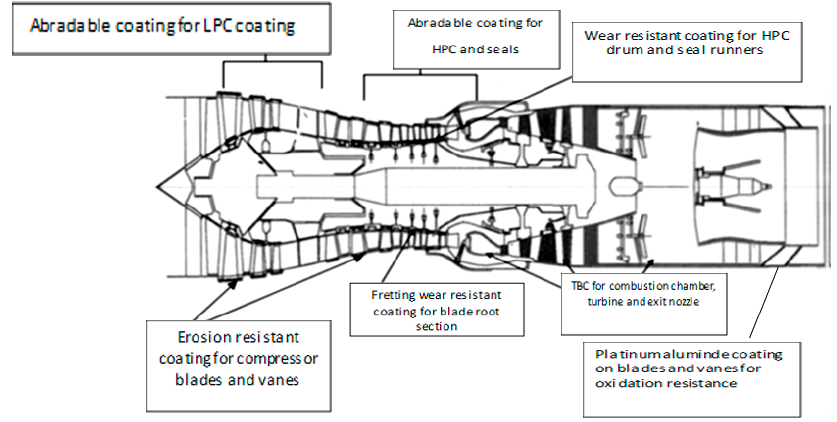
Figure 2. Wear problems and hardface coatings for hot gas path components in a gas turbine (Rajendran et al., 2012).